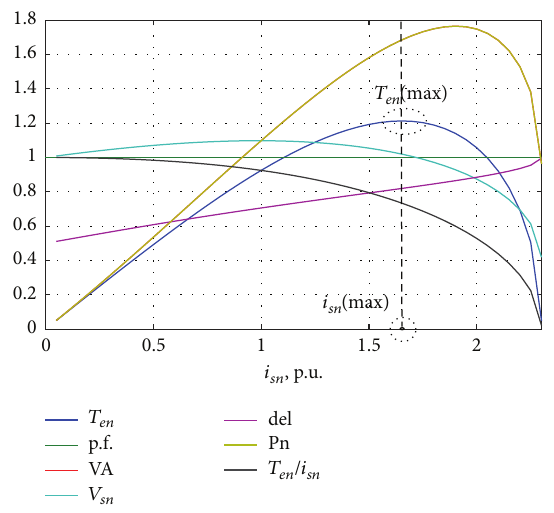
Figure 5: Performance characteristics of PMSM for cos 𝜙 = 1